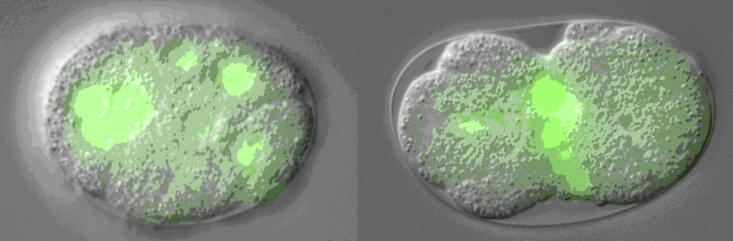
Simultaneous knockdown of MAU-2 and SCC-3 (left panel) or of PQN-85 and SCC-3 (right panel) consistently produces severe chromosome segregation defects in early worm embryos where the chromosomes do not appear to move to either pole.